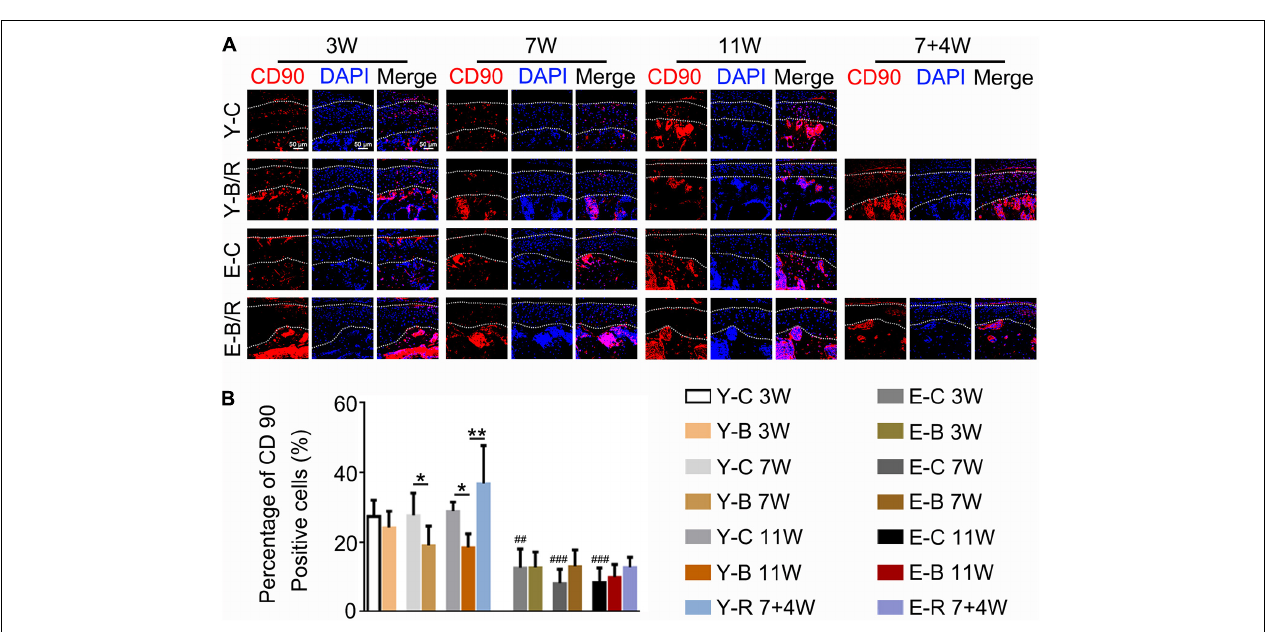
FIGURE 12 | (A) Representative CD90 immunofluorescence staining. Bars = 50 µ m. (B) Comparisons of the percentage of CD90-positive cells in the cartilage between the groups. Data are presented as mean ± SD. Unpaired t -test was used for comparisons between the age-matched control and BAC groups. One-way ANOVA was used for comparisons among the age-matched control, BAC, and BAC removal groups, and the comparisons among the six time points in control groups. n = 6. * P < 0.05, ** P < 0.01 for the differences between all BAC and removal groups and the age-matched control groups. ## P < 0.01, ### P < 0.001 for the differences between each time points control groups and the younger 3-week control group. For grouping and time points, please refer to Figure 1A .